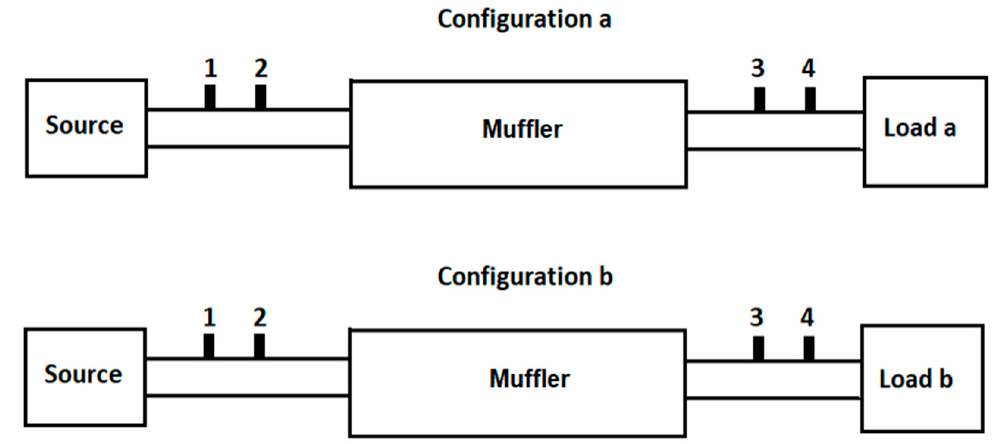
Figure 3. Measurement set-up according to the two-load method.